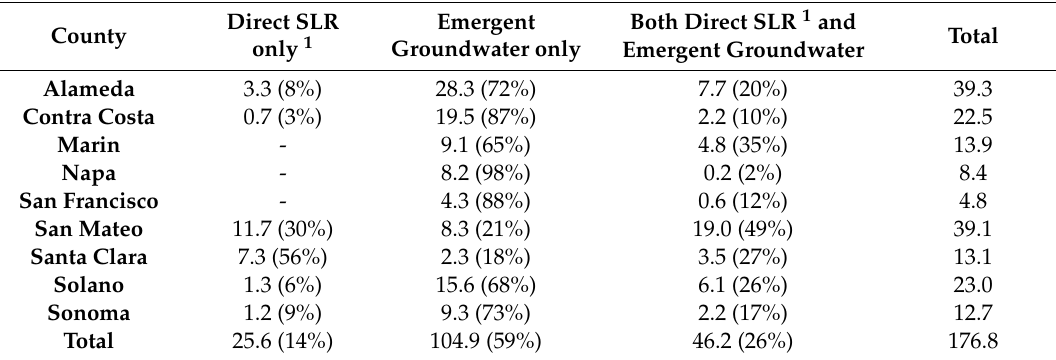
Table 3. Comparison of flood extent from direct tidal flooding due to SLR and groundwater emergence due to SLR